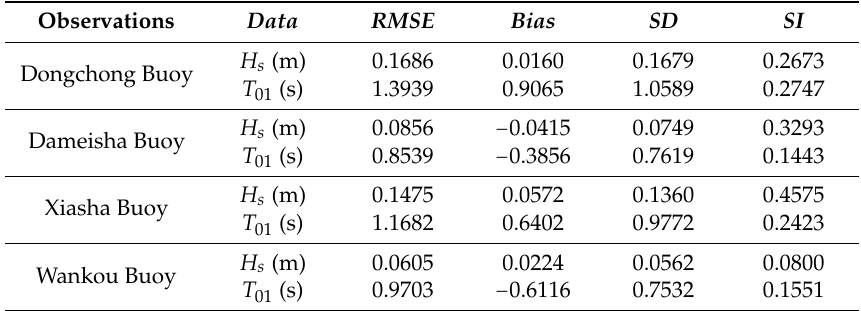
Table 6. Summary of the statistical errors for the simulations during Typhoon Matmo process from 20 to 24 July 2014.